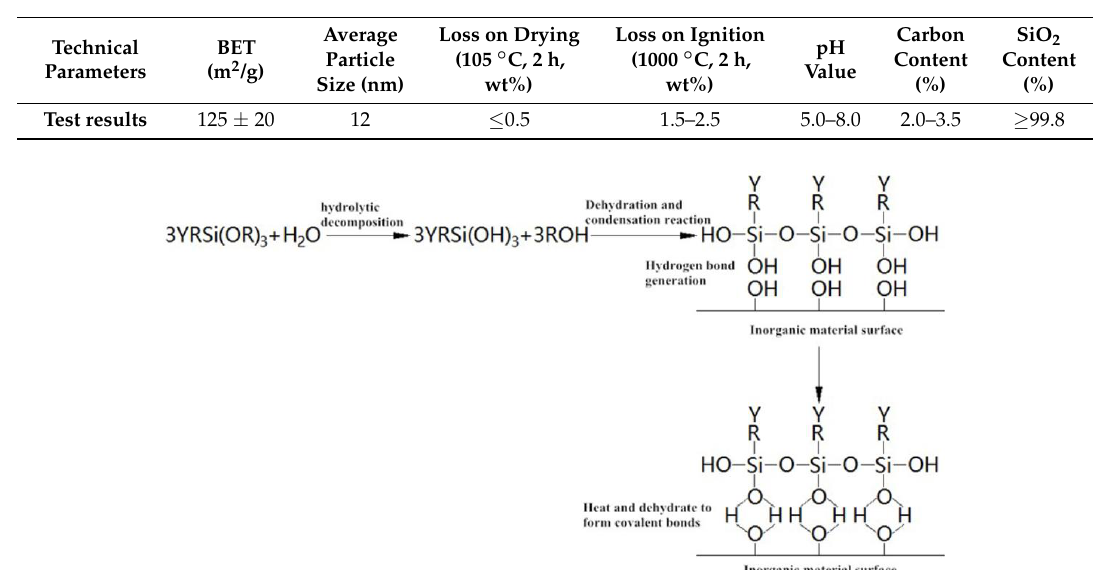
Table 3. Technical parameters of nano hydrophobic silane silica (NHSS).